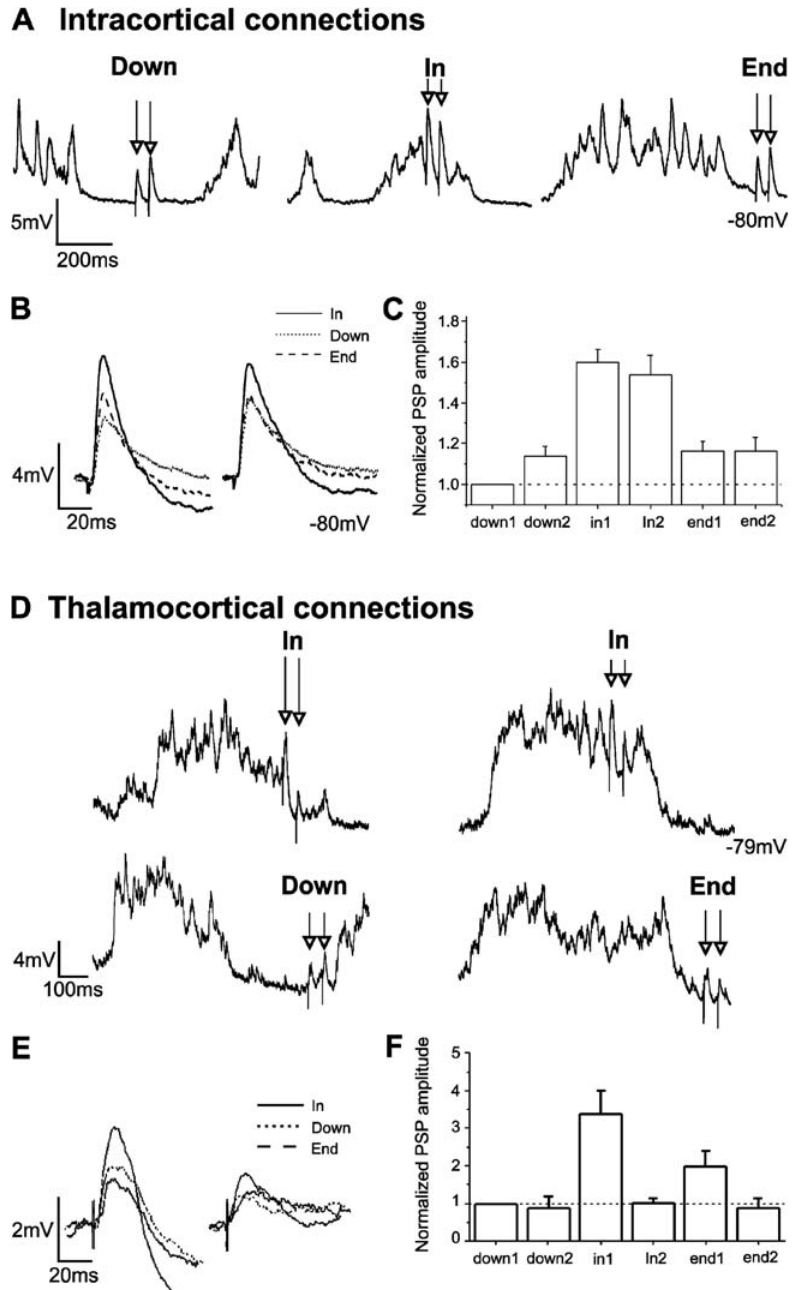
Figure 4. Paired pulse facilitation in up versusdown states in the cortexinvivo.A. Raw traces of pairs of intracortical PSPs occurring during Down (down states), In (up states) and End (200 ms following up states) periods during an intracellular recording in vivo in the cat primary visual cortex. B. Averaged amplitudes of the first and second intracortical PSPs in the pair occurring in the three situations ( Down, In and End ) shown in A. C. Bar diagram illustrating the relative amplitudes of first and second intracortical PSPs in the three periods ( Down, In and End ) all of them normalized with respect to the amplitude of the first PSP in the down state, which is therefore represented as amplitude 1 (n=9 neurons). D. Two different examples of thalamocortical PSPs occurring during the up states ( In period; top traces): one triggering the initiation of a down state (left), and both PSPs occurring during the up state (right). The bottom traces display the PSPs occurring during the down state ( Down period; left) and right after the end of an up state ( End period; right). All the traces in D correspond to a recording from the same neuron. E. Averaged amplitudes of the first and second thalamocortical PSPs in the pair occurring in the three situations ( Down, In and End ) shown in D. F. Bar diagram illustrating the relative amplitudes of first and second thalamocortical PSPs in the three conditions ( Down, In and End ) all of them normalized with respect to the amplitude of the first PSP in the down state (n=9 neurons).